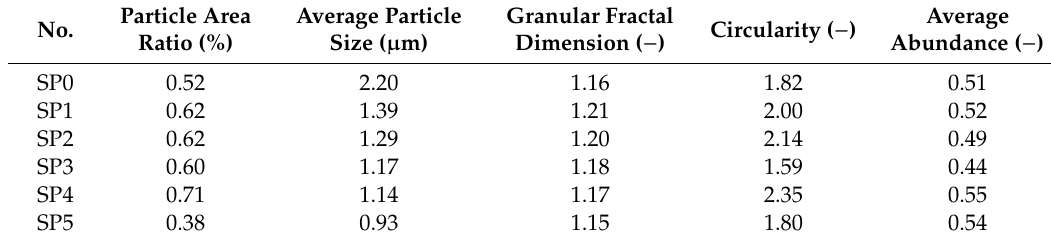
Table 12. Microparticle parameters.